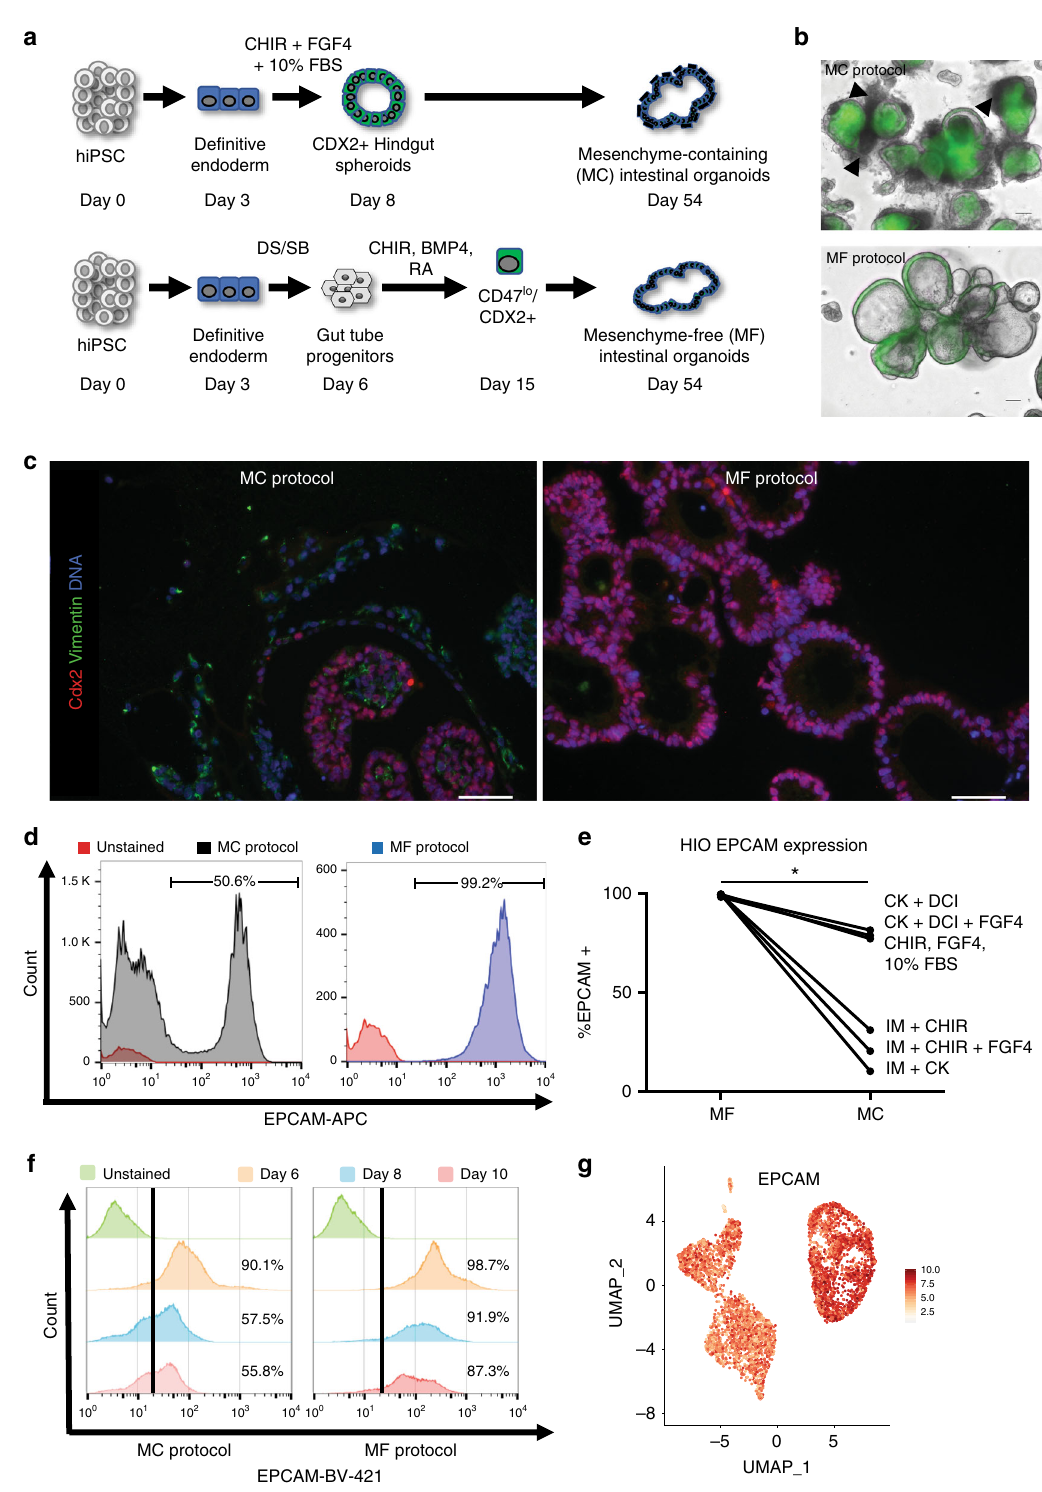
Fig. 5 iPSC-derived HIOs grow in the absence of mesenchymal support. a Experimental schematic of MF and MC directed differentiations. b Light microscopy representative micrographs of merge images from BU1CG-derived HIOs cultured under MC vs MF conditions (scale bar = 100 μ m, representative of n = 3 differentiations). c Representative fl uorescent micrographs of HIOs derived using the MC vs MF Protocol stained for the mesenchymal marker Vimentin along with Cdx2 (scale bar = 50 μ m, representative of n = 5 organoids from n = 3 differentiations). d Flow Cytometry of single-cell suspensions from HIOs differentiated using the MC vs MF protocol stained with the epithelial marker EpCAM. e Comparison of the % of EPCAM + cells as measured by fl ow cytometry in HIOs cultured in different media conditions at day 54 of differentiation (paired Student ’ s t -test, * p < 0.05). f Flow cytometry for EpCAM expression of cells at days 6, 8, and 10 of both MC and MF differentiations. g UMAP representation of EpCAM expression at days 6 and 13 of differentiation by